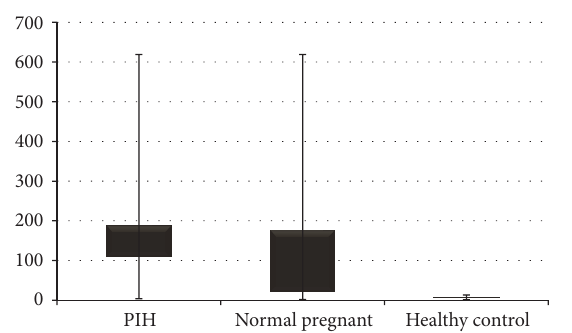
Figure 1: Comparison of serum VEGF level between PIH, normal pregnant, and control